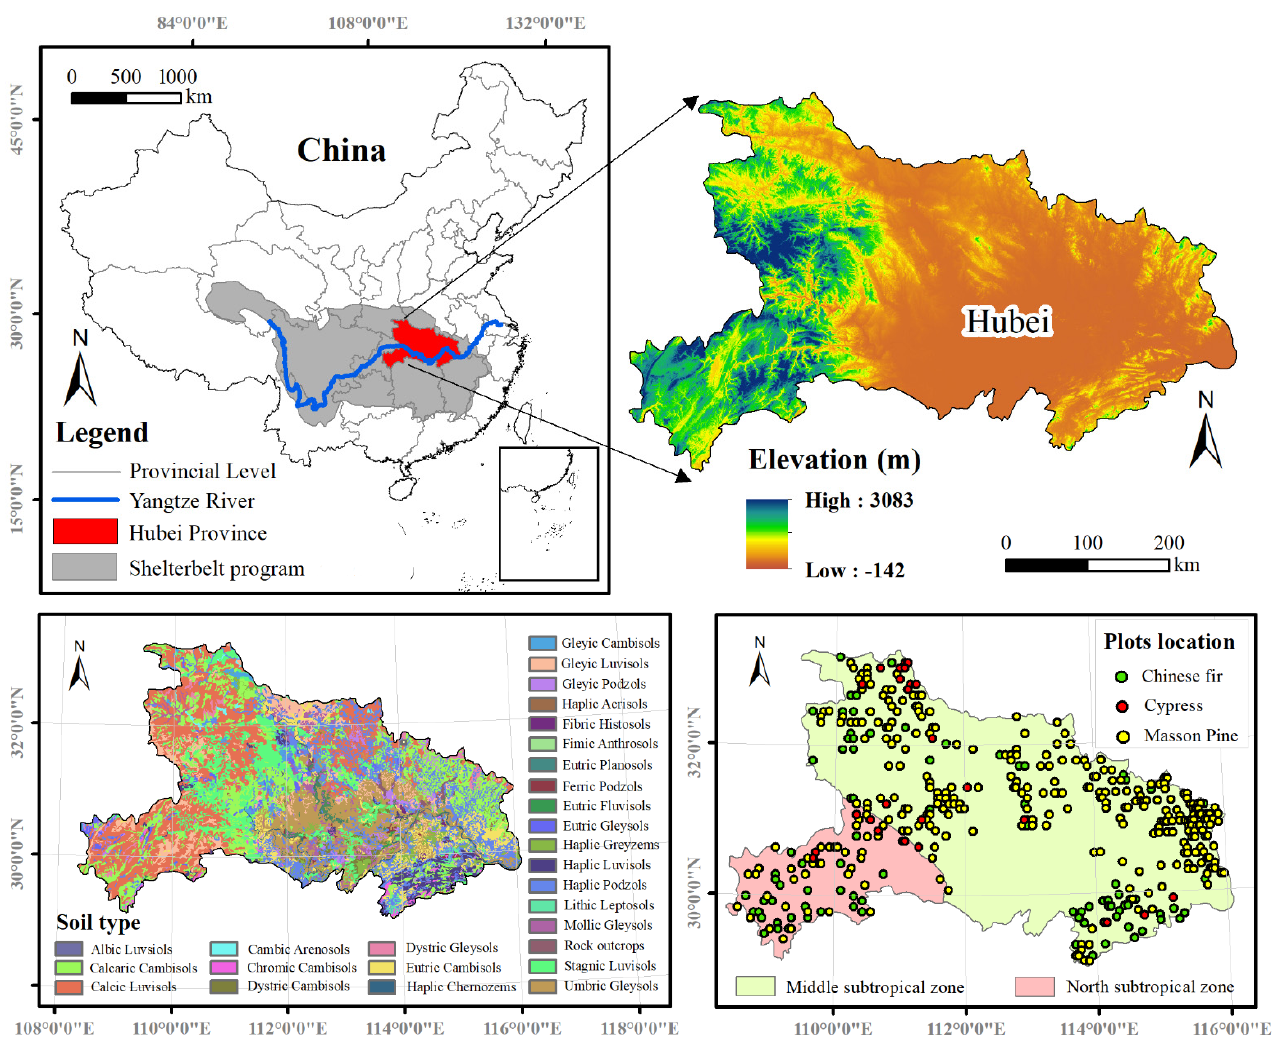
Figure 1. Location, altitude, soil type, climate subdivision and sampling plots distribution of the study are.